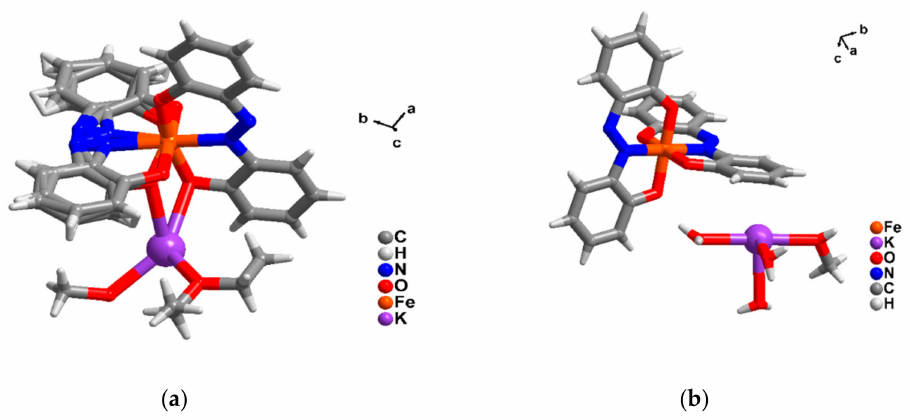
Figure 2. The asymmetric unit of ( a ) K[Fe(azp) 2 ] · MeOH · Et 2 O ( 1-ref ) from ref [9]